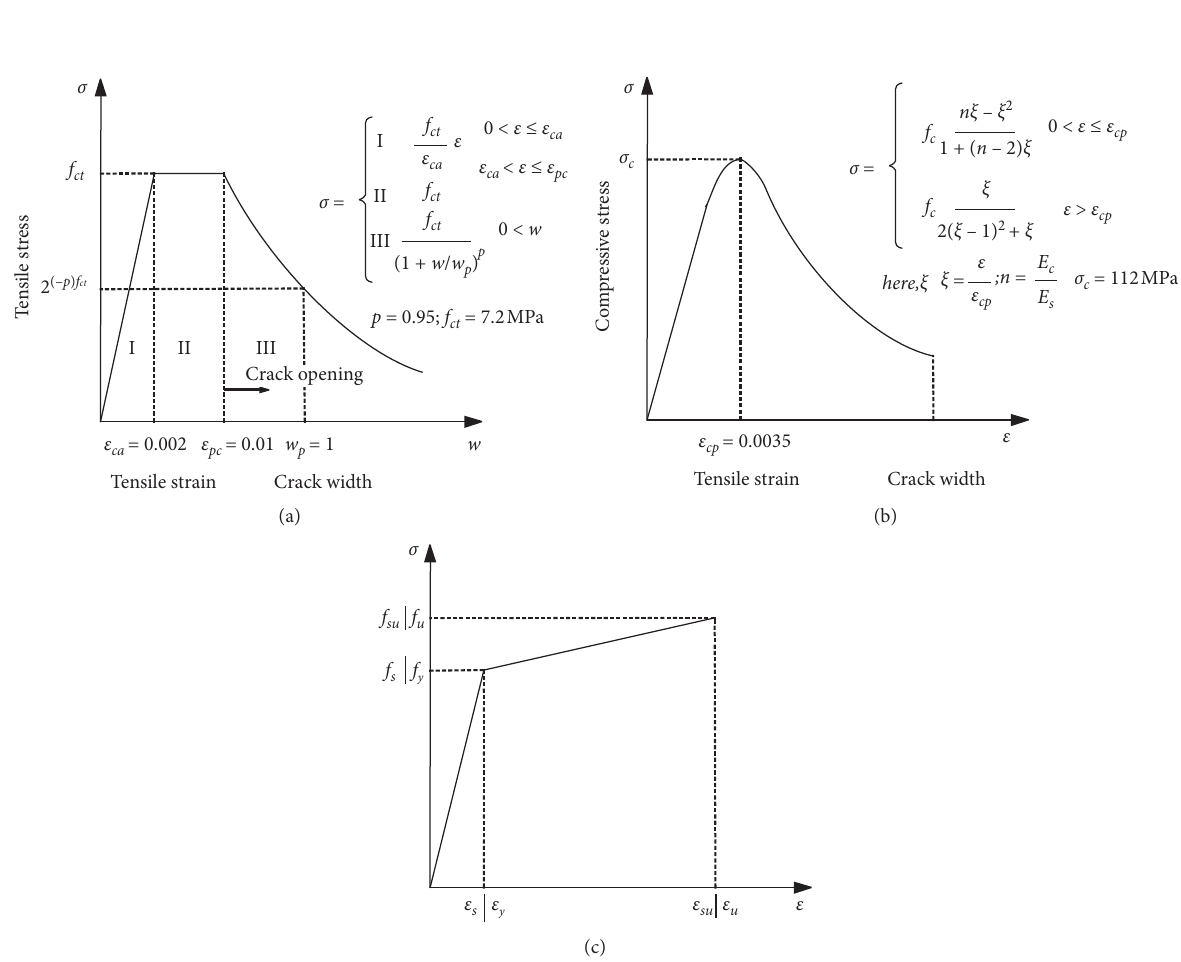
Figure 13: The tension [43] and compression [44] constitutive of UHPC and the constitutive of steel plate [45]. (a) Tensile constitutive model of UHPC. (b) Compressive constitutive model of UHPC. (c) Constitutive model of steel